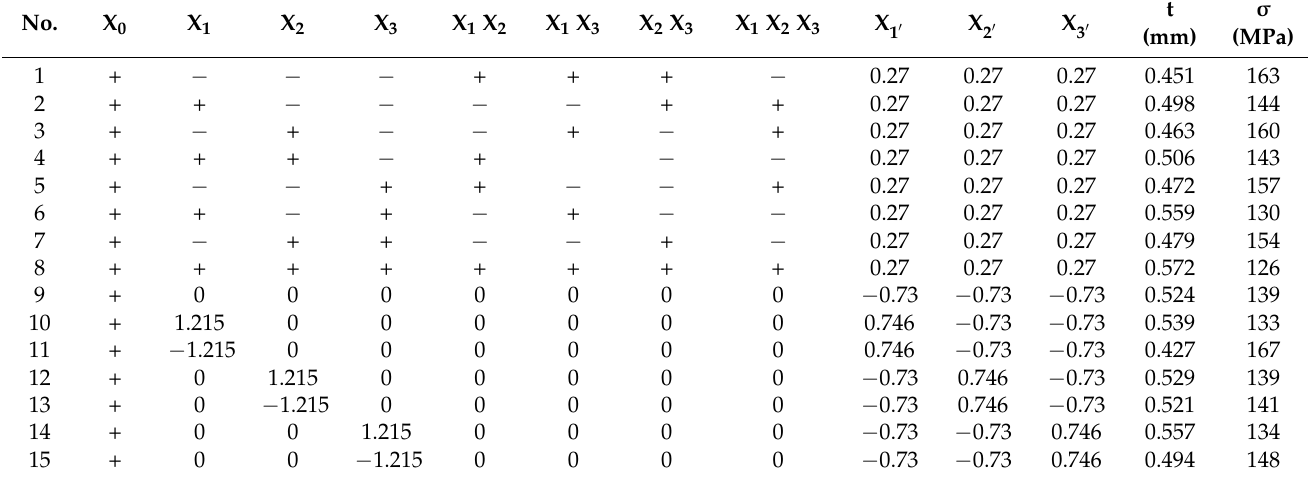
Table 7. The set of